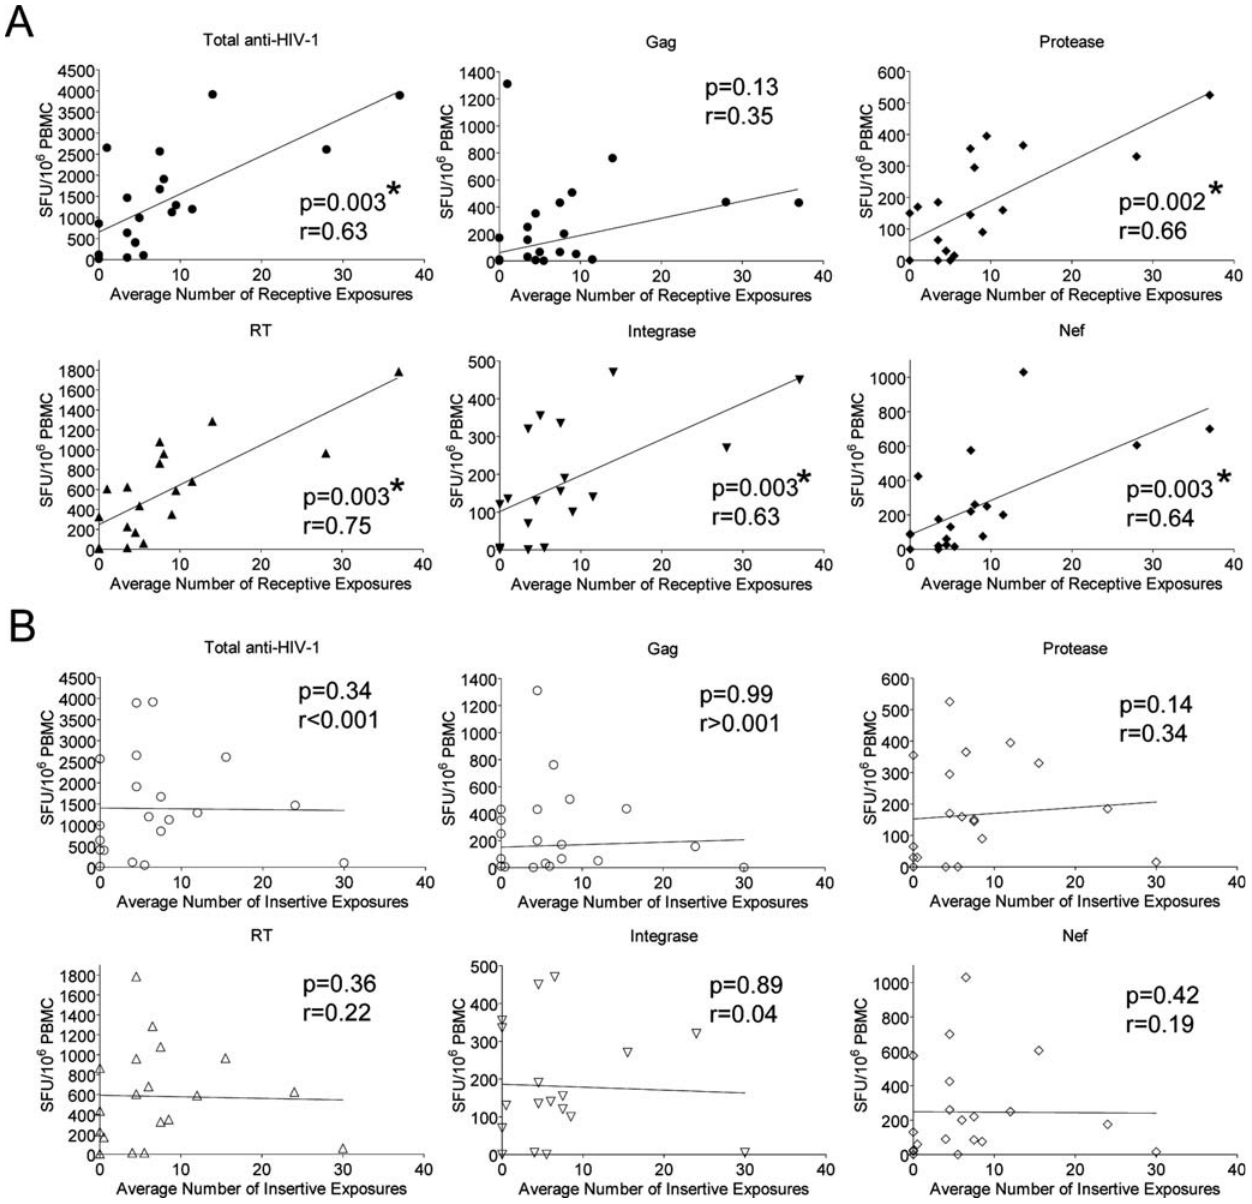
Figure 3. Direction of exposure and T cell IFN- c response correlations. IFN- c T cell responses from the viremic partner (VP) group were plotted against the corresponding average number of unprotected receptive (A) or insertive (B) anal exposures to a partner’s HIV-1. Significant correlations (denoted by *) were determined by two-tailed nonparametric spearmans correlation, spearman r (r), and linear regression analysis was plotted as straight